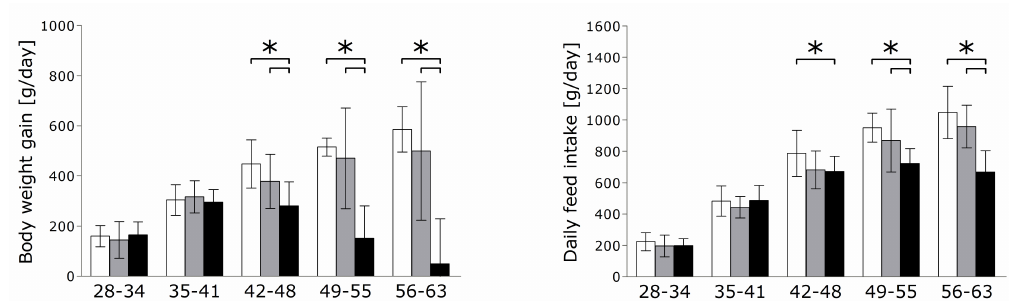
Figure 2. Daily weight gain and feed intake of piglets fed variable dietary amounts of P and Ca. Data refer to the weekly means of body weight gain and feed intake throughout the feeding trial (details are displayed in Table S2). Low P diet (white bars); Medium (recommended) P diet (gray bars); High P diet (black bars); * p < 0.05.